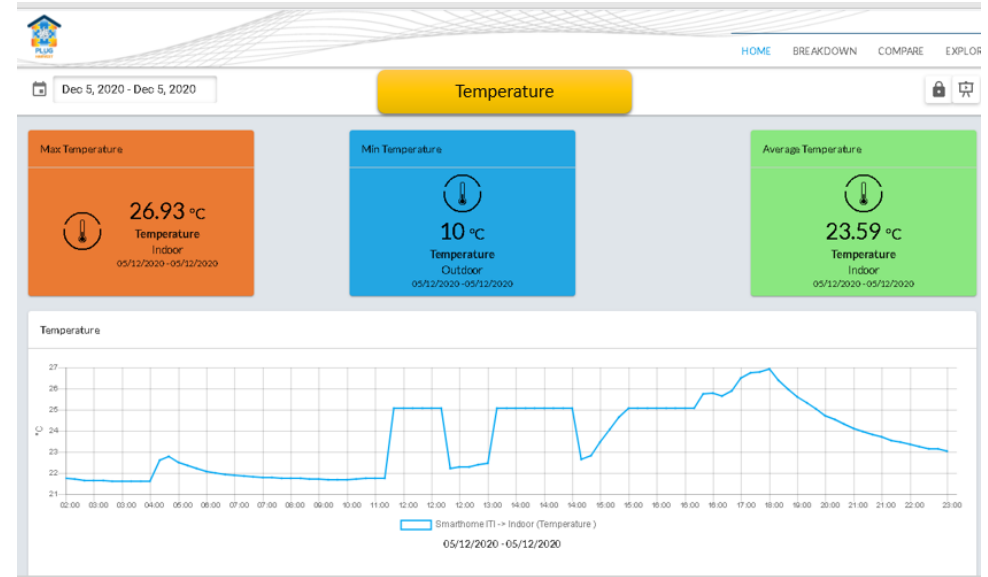
Figure 6. Gateway-validation and visualization from the sensors data and information.